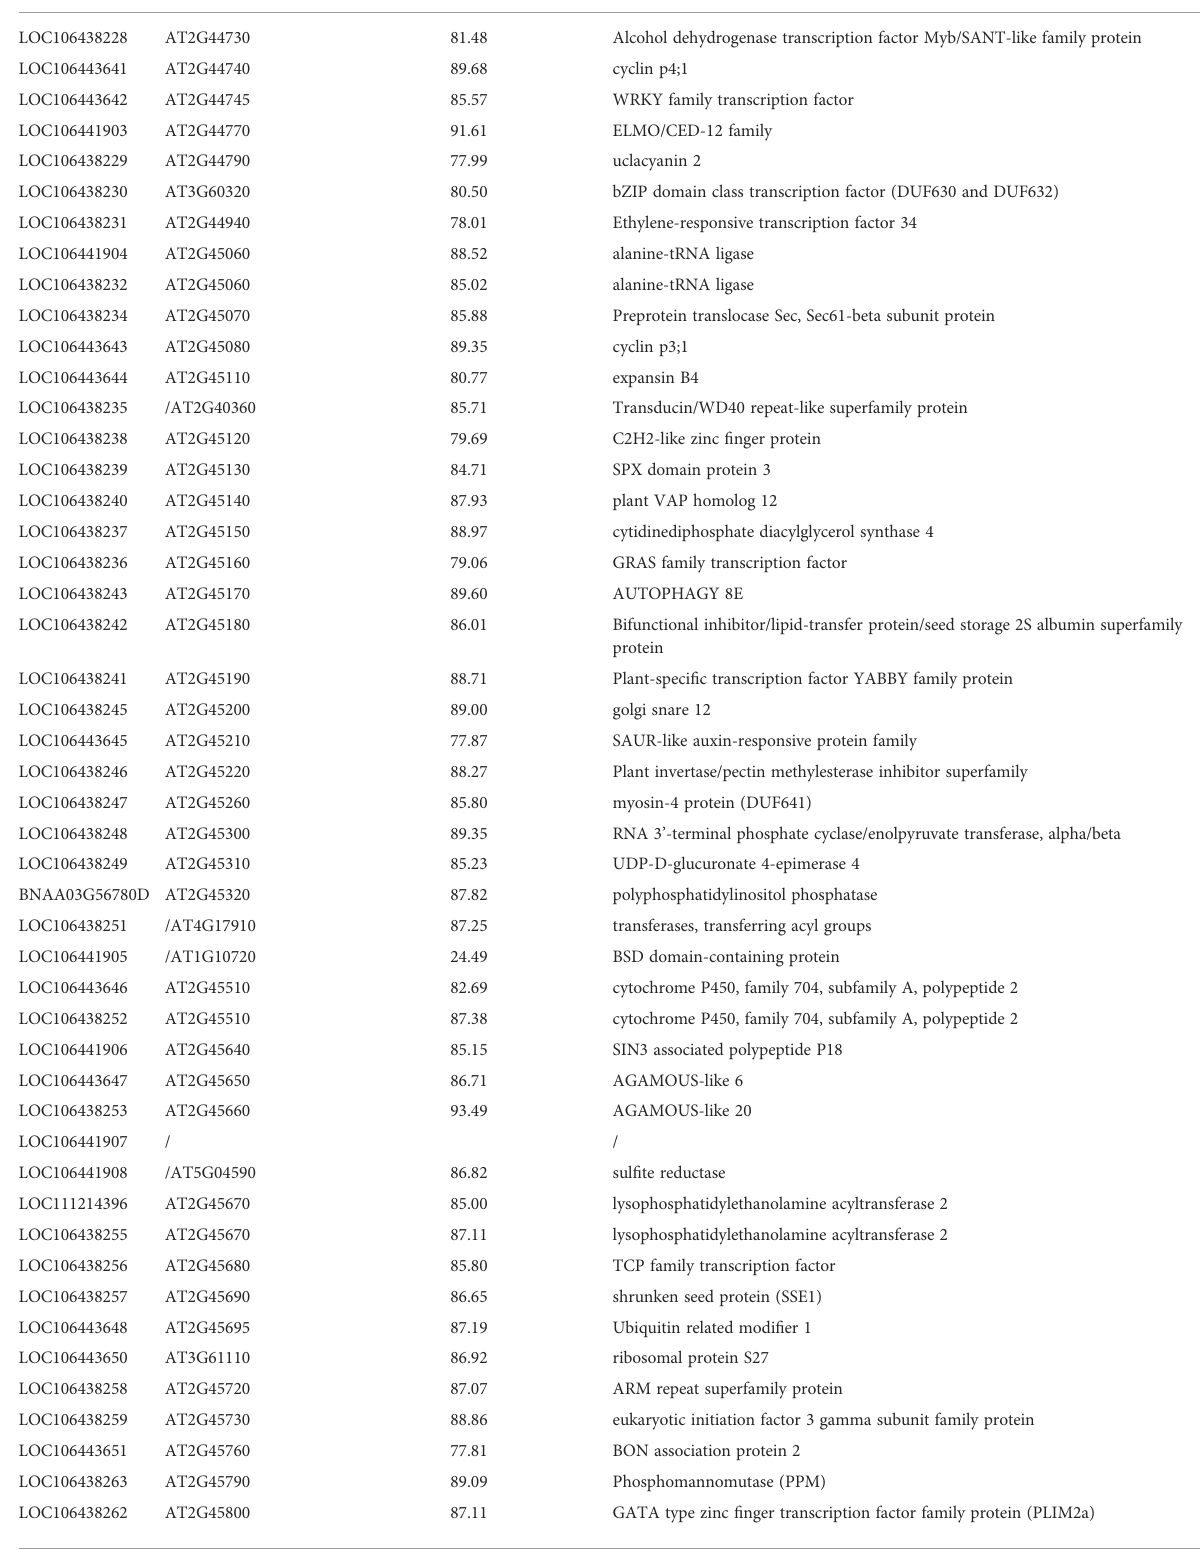
TABLE 3 Homologs of candidate genes in A. thaliana and functional annotation. Gene ID ID in A. thaliana Sort by percent identity (%) Description of gene functions in A.